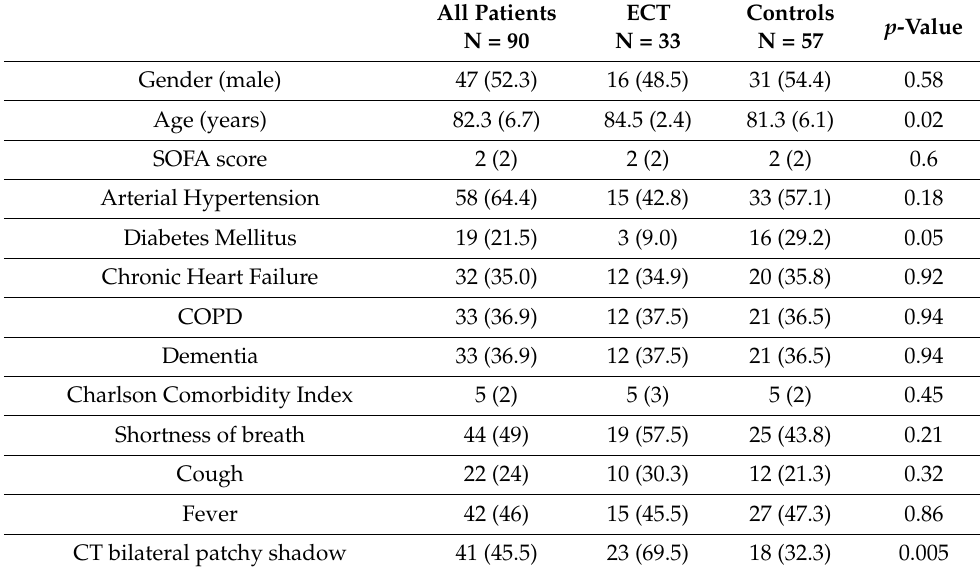
Table 1. Clinical characteristics of the study